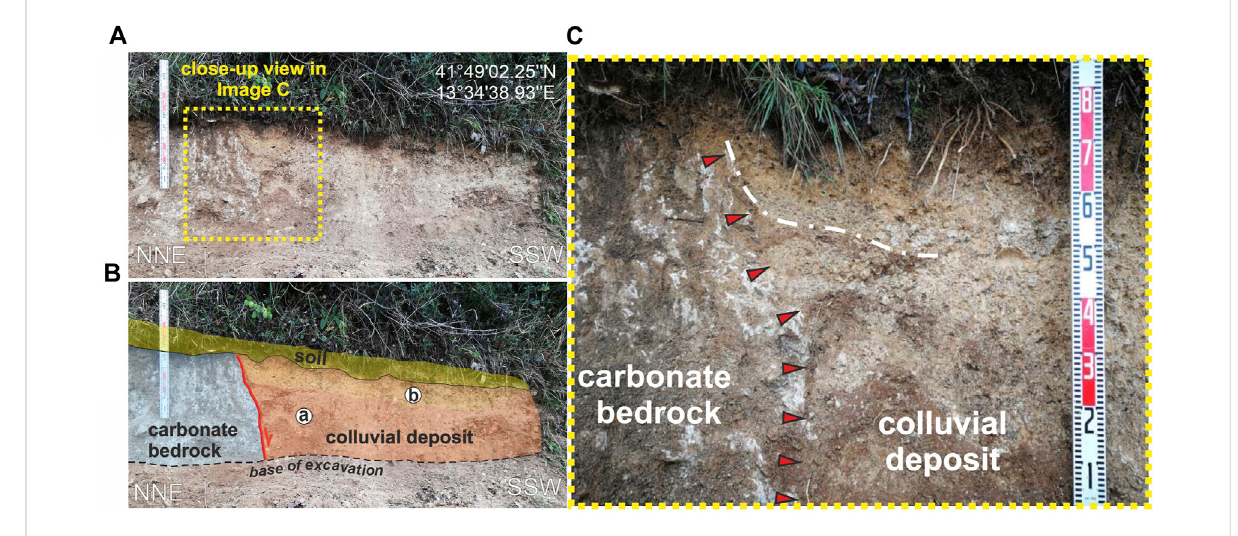
FIGURE 7 (A) Handmade excavation made at the “ La Stretta-b ” site; wall of the excavation that shows the colluvial deposits (in the hanging wall) placed in contact with the carbonate bedrock (in the footwall) caused by the fault; the yellow box shows a detail of the excavation in ‘ C ’ . (B) Stratigraphic scheme of the excavation wall; a and b indicate the sub-units of the colluvial body. (C) Details of theshear zone, marked by red arrows, betweenthe limestone and the colluvial deposits and a detail of the deposit dragged along the fault plane, marked by white dash-dotted